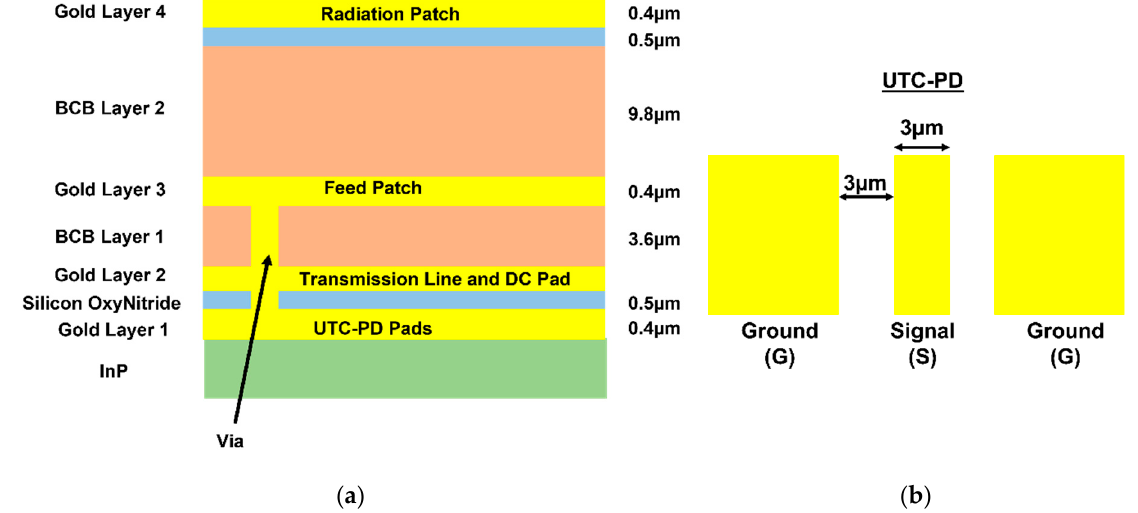
Figure 1. ( a ) Proposed epitaxial layer stack-up of InP, ( b ) pad dimensions of UTC-PD.